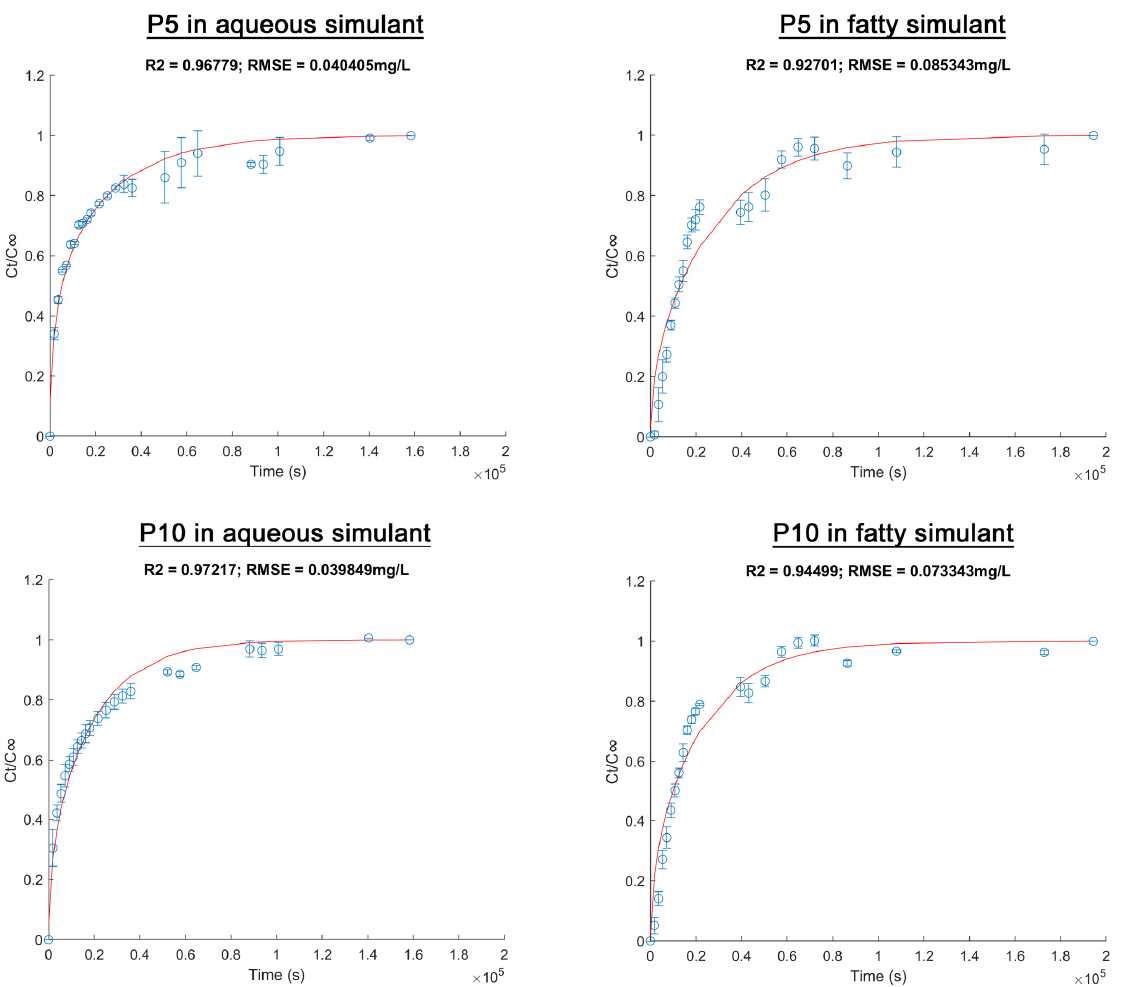
Figure 4. Release of allyl isothiocyanate from poly(lactic acid)/inclusion complex films to food simulants at 25 ◦ C. The red line shows the modeled data based on experimental results (blue points). Fickian diffusion model (R 2 > 0.95 y RSME < 0.08). In all cases, a burst release of AITC was behavior depended on the inclusion complexes’ concentration and the food